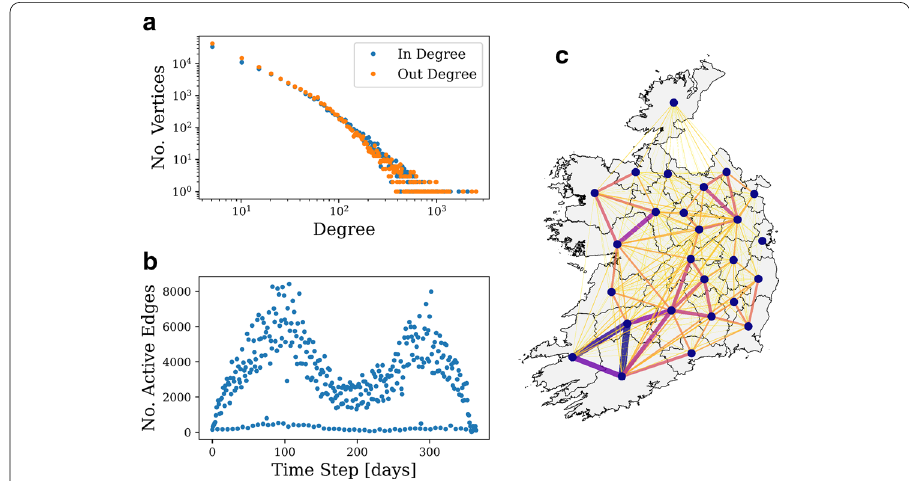
Fig. 3 a In- and out-degree of the network aggregated over the entire year worth of data. b Time series of number of active edges per day in the network. c Trades at the level of counties aggregated over the observation period. The number of trades is indicated by the edge width and colour